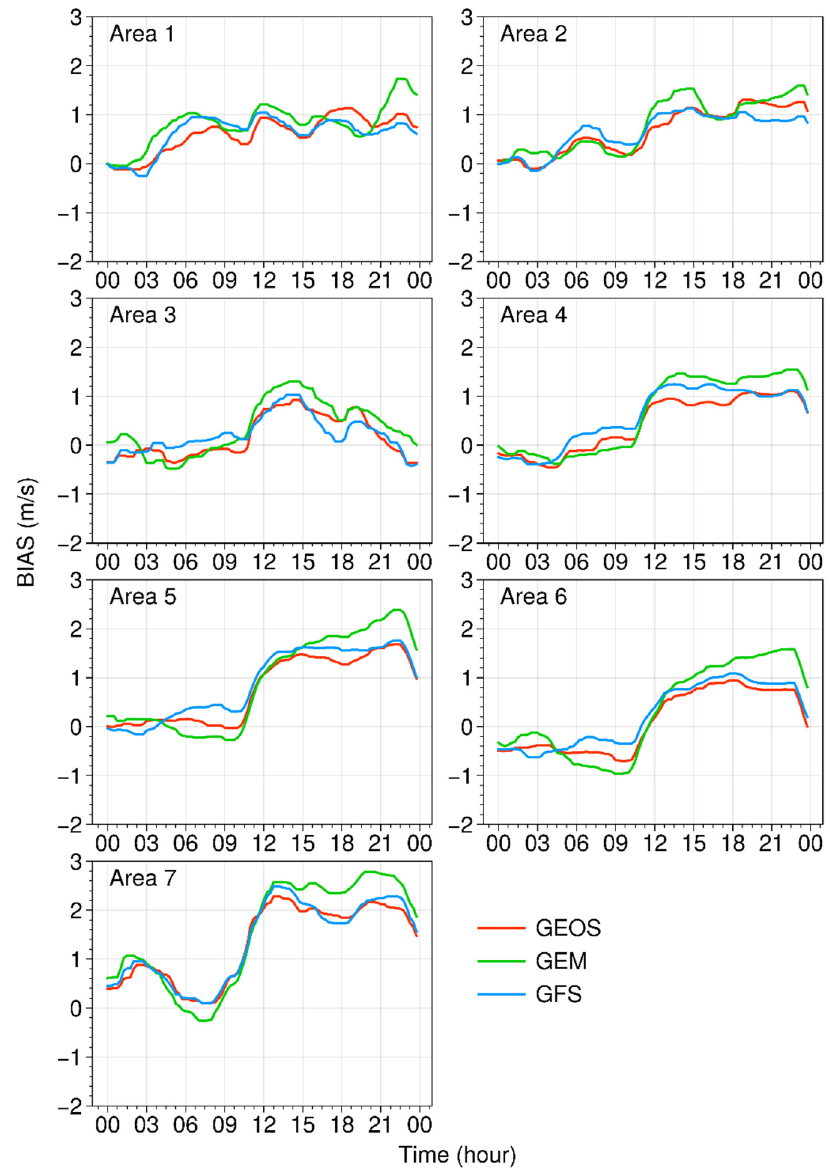
Figure 7. The BIAS of the wind forecasts of the three ensemble groups in the seven sub-areas. The x-axis represents the time (UTC).